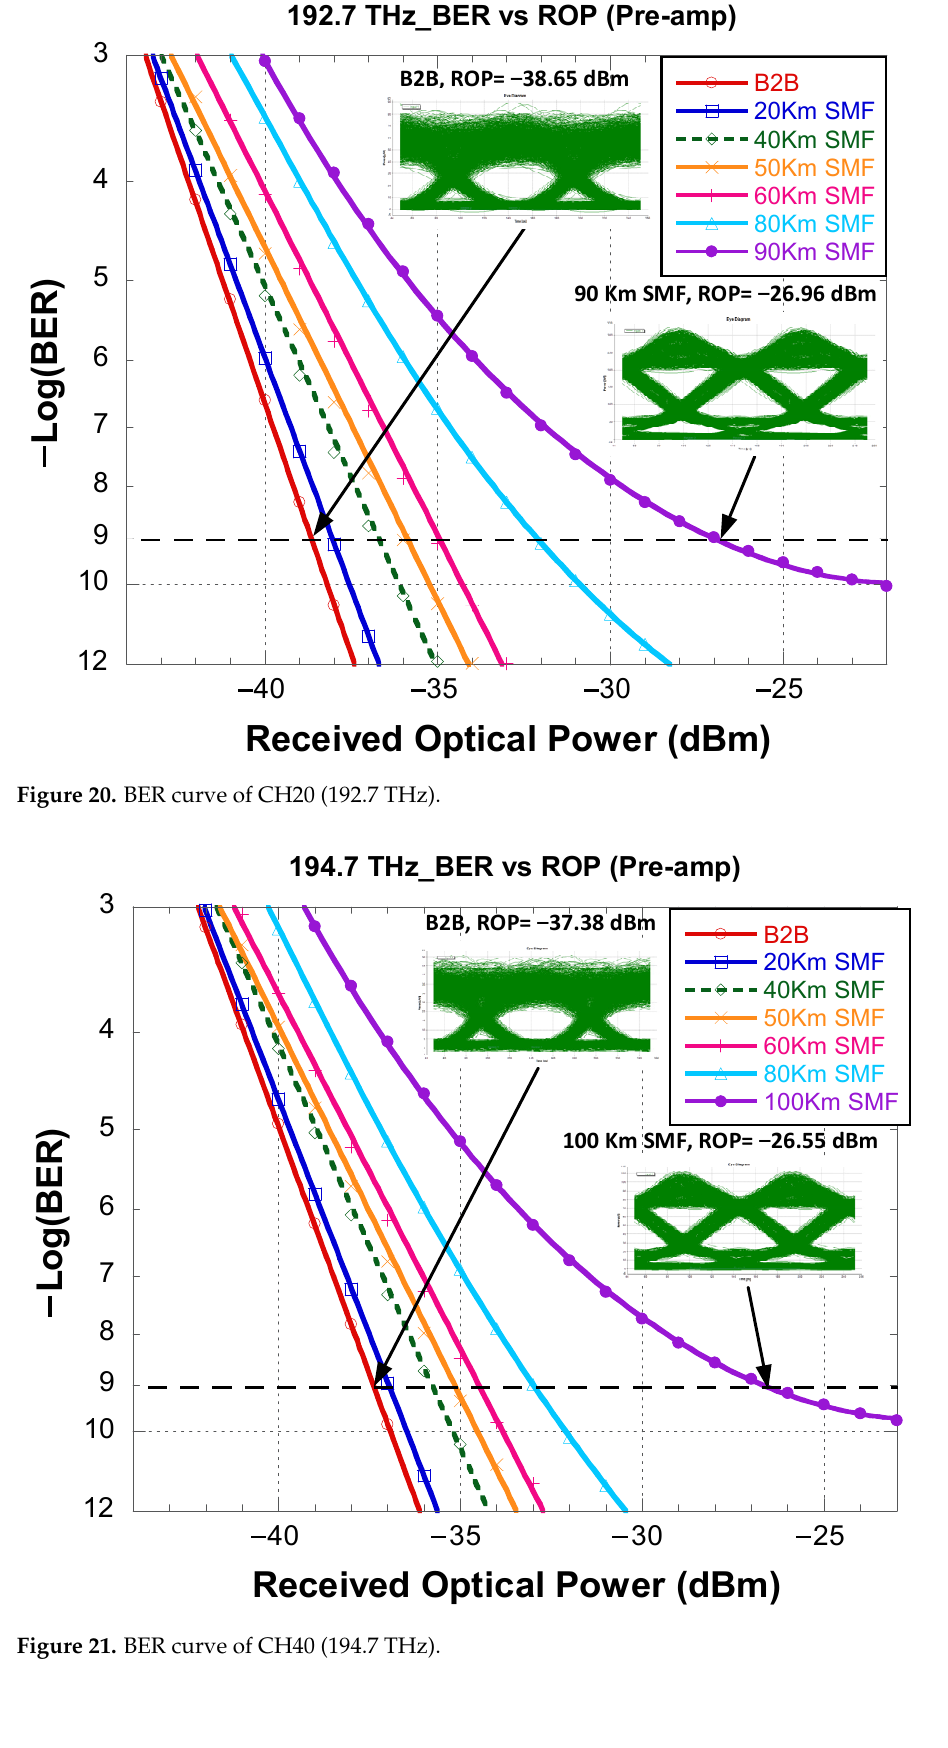
Figure 19. BER curve of CH1 (190.8 THz).